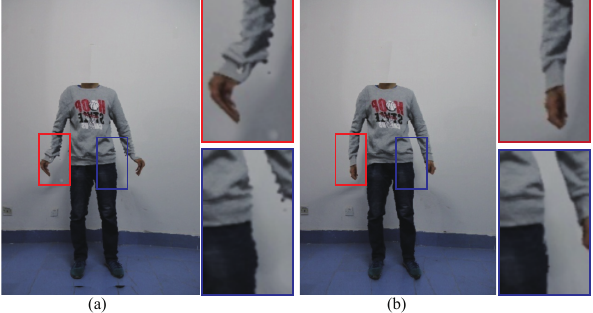
Fig. 6 Body shape warping results: (a) using MLS, (b) using